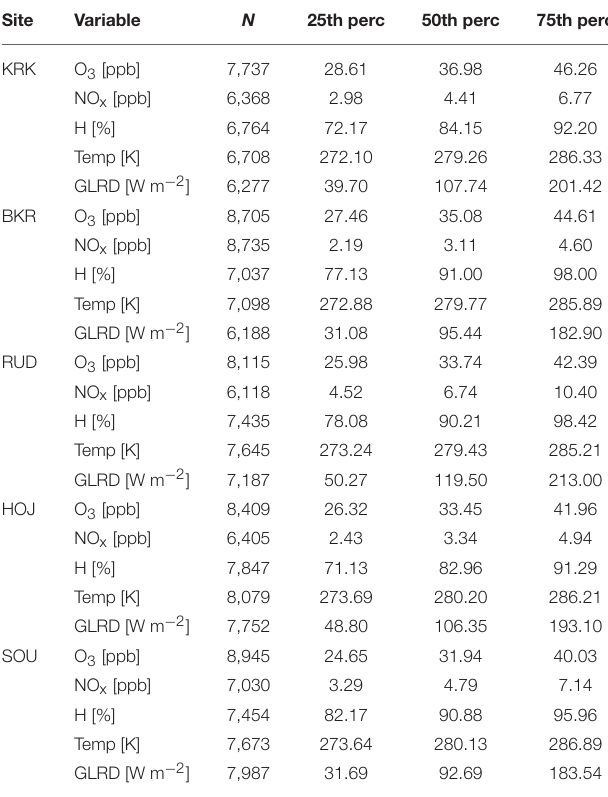
TABLE 2 | Descriptive statistics for included variables at all five sites (calculated from daily